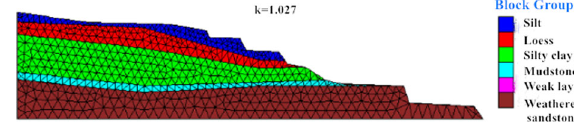
Fig. 11 Calculation model for section P-1